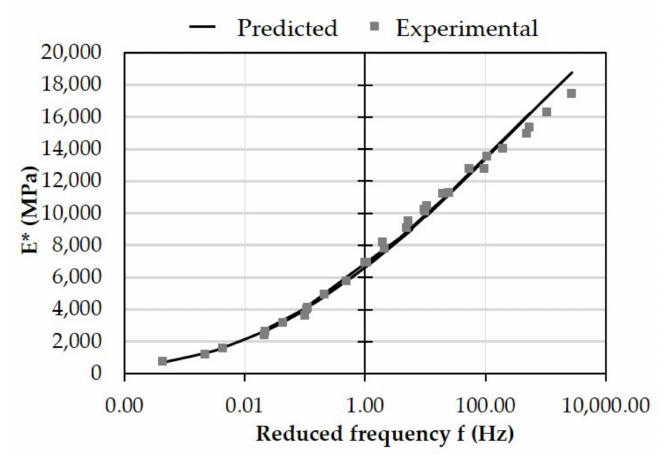
Figure 6. Example of Huet–Sayegh master curve